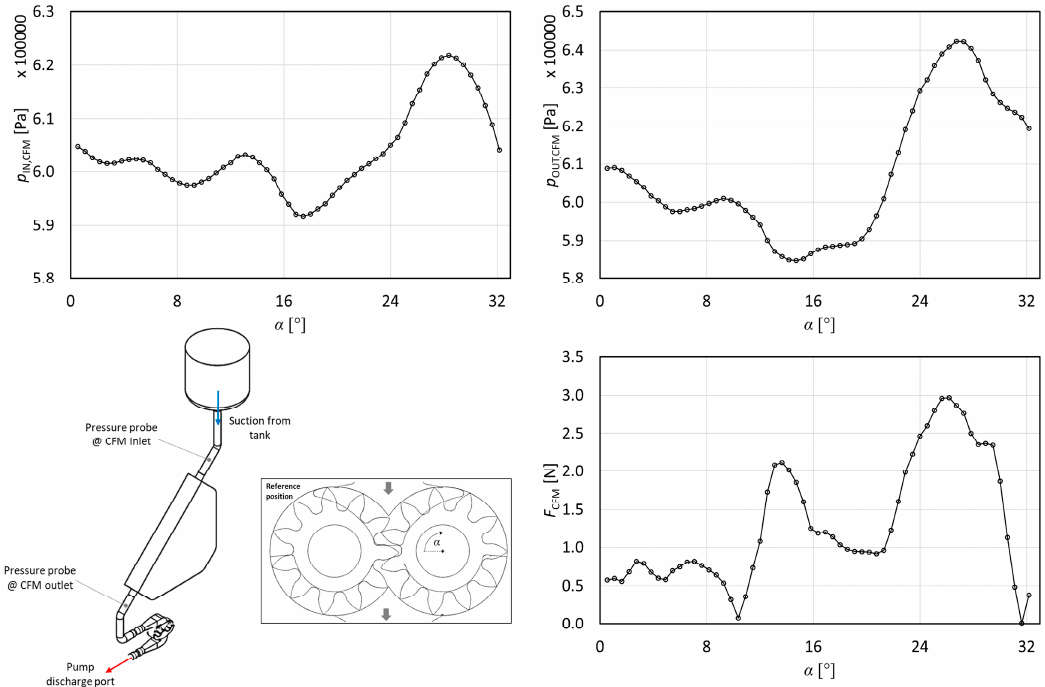
Figure 12. Pressure pulsation at the inlet and outlet sections of the CFM and the force trends according to the angular position of the gear pump wheel (see reference position).